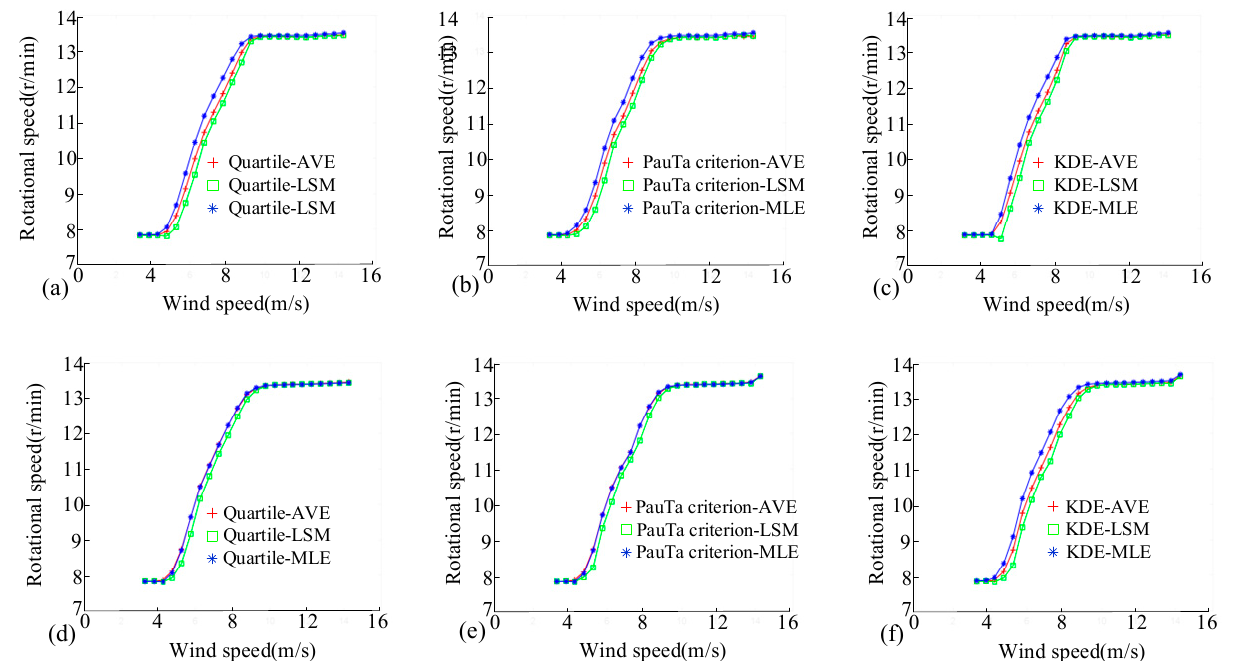
Figure 10. Influence of Binning benchmark on wind–rotational speed curve. ( a ) wind speed and rotational speed curves obtained by binning wind speed data using three Quartile-based methods; ( b ) wind speed and rotational speed curves obtained by binning wind speed data using three PauTa- based methods; ( c ) wind speed and rotational speed curves obtained by binning wind speed data using three KDE-based methods. ( d ) wind speed and rotational speed curves obtained by binning power data using three Quartile-based methods. ( e ) wind speed and rotational speed curves obtained by binning power data using three PauTa-based methods. ( f ) wind speed and rotational speed curves obtained by binning power data using three KDE-based methods.